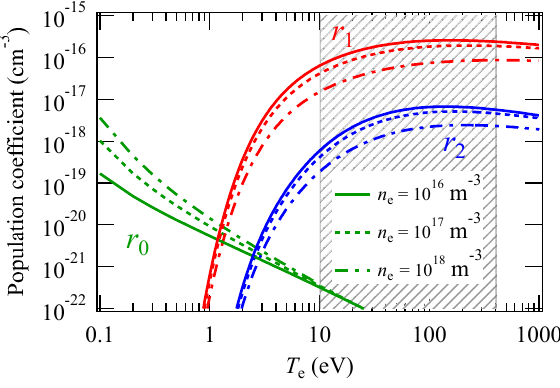
Figure 4. Population coe ffi cients for p = 6. The green, red, and blue lines represent r 06 , r 16 , and r 26 , respectively. The solid, dashed, and dash-dotted lines represent those at n e = 10 16 , 10 17 , and 10 18 m − 3 , respectively.